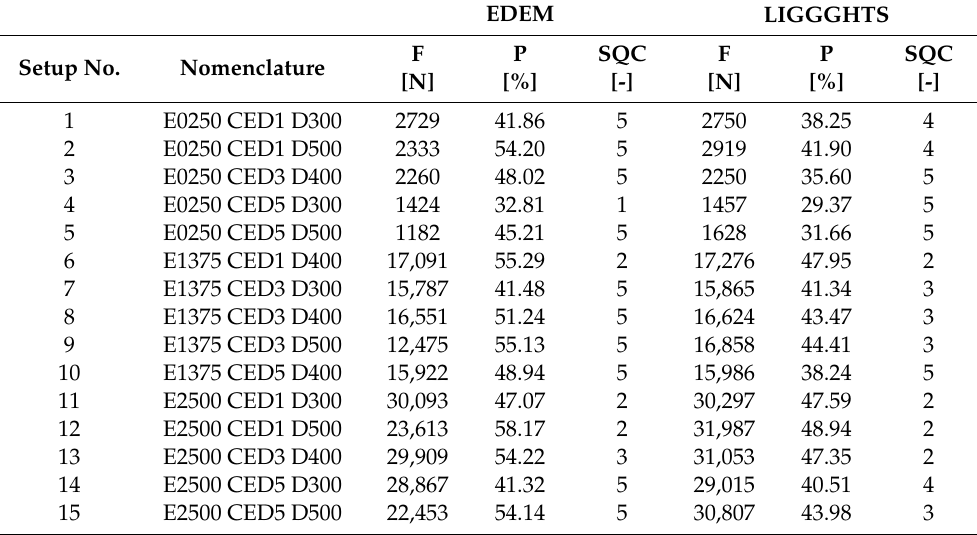
Table 6. Results obtained in the simulations used for the preliminary analysis of the DEM models. EDEM LIGGGHTS Setup